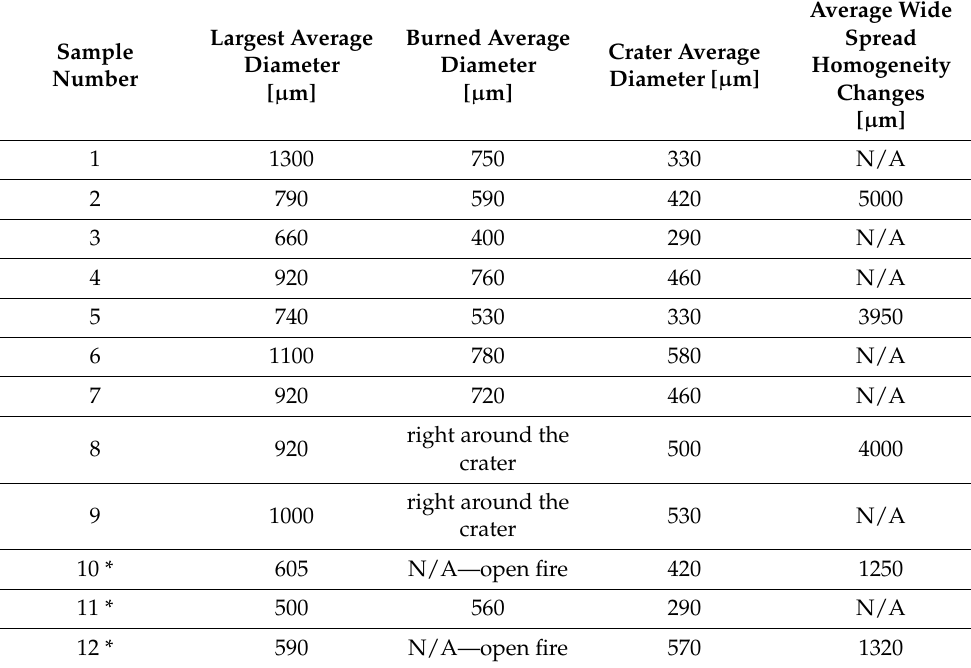
Table 4. Description of damage caused by electric discharge on each